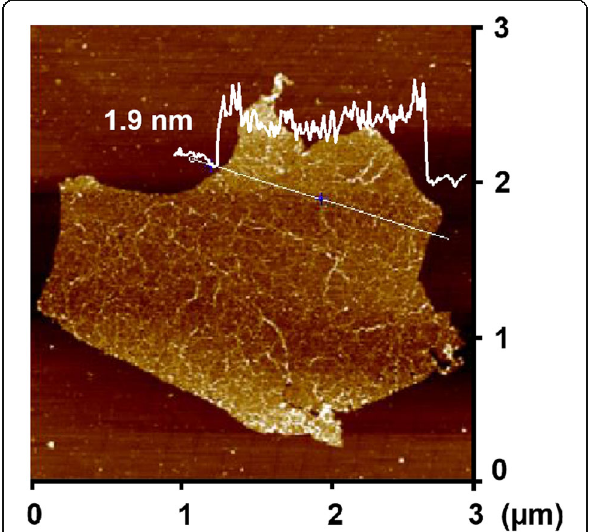
Fig. 2 AFM image of GO sheets after reaction with Fenton reagent under UV irradiation for 1